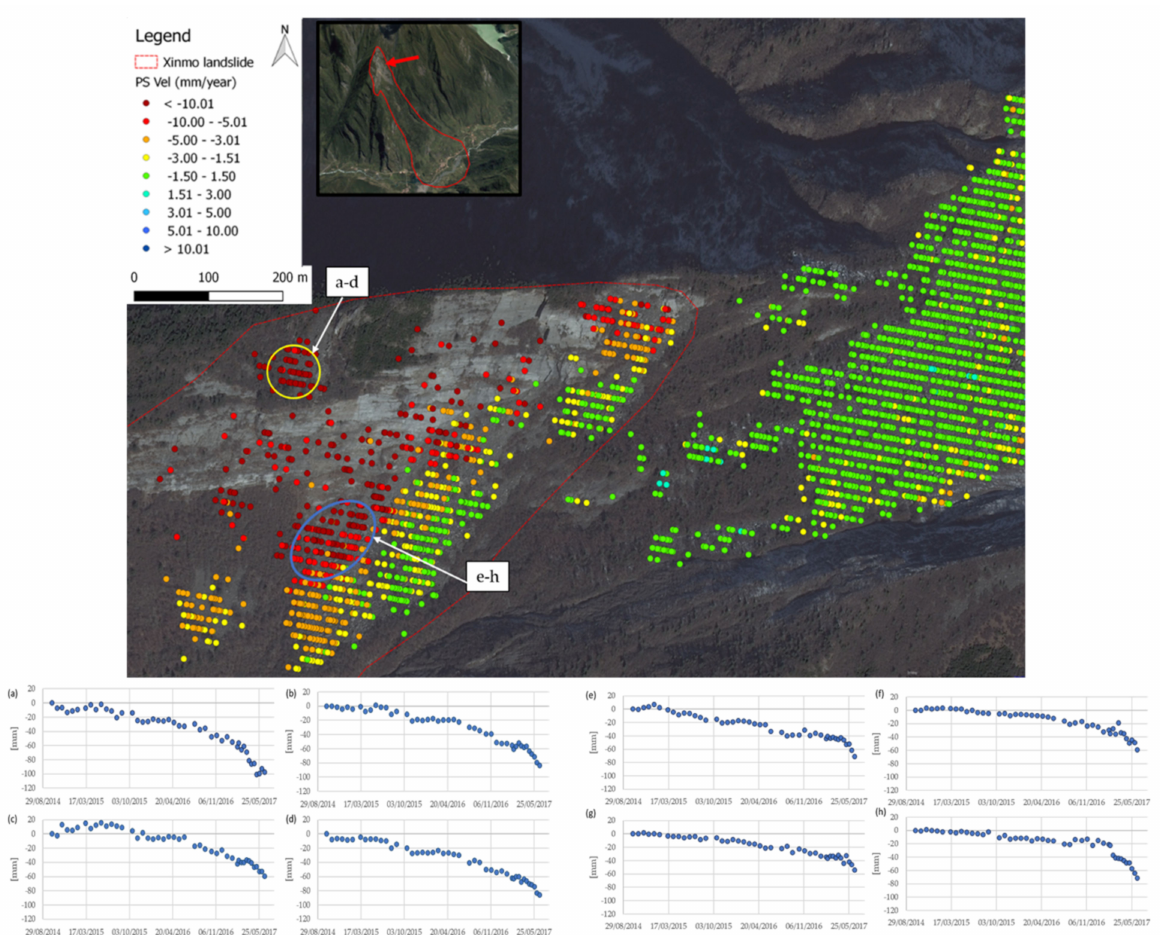
Figure 13. A-DInSAR results. Average velocity map and the time series of displacement retrieved in correspondence with the yellow circle ( a – d ) and the blue circle ( e – h ) showing clear non-linear deformational behaviour. The dashed polygon represents the landslide boundary. The insert shows the location of the analysed area (from [39], modified). (Lat: 32.079638 ◦ ; Lon: 103.662088 ◦ ;